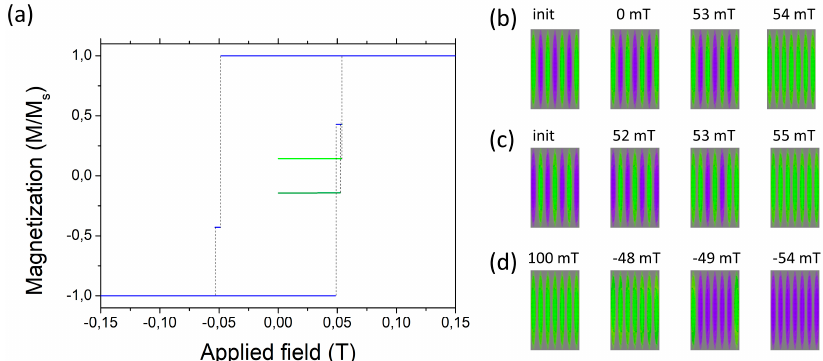
Figure 7. ( a ) Hysteresis loop for the system of seven ellipsoids. The configuration sequence when starting from ( b ) AFu and ( c ) AFd. ( d ) the sequence in the reversal of the FM configuration.